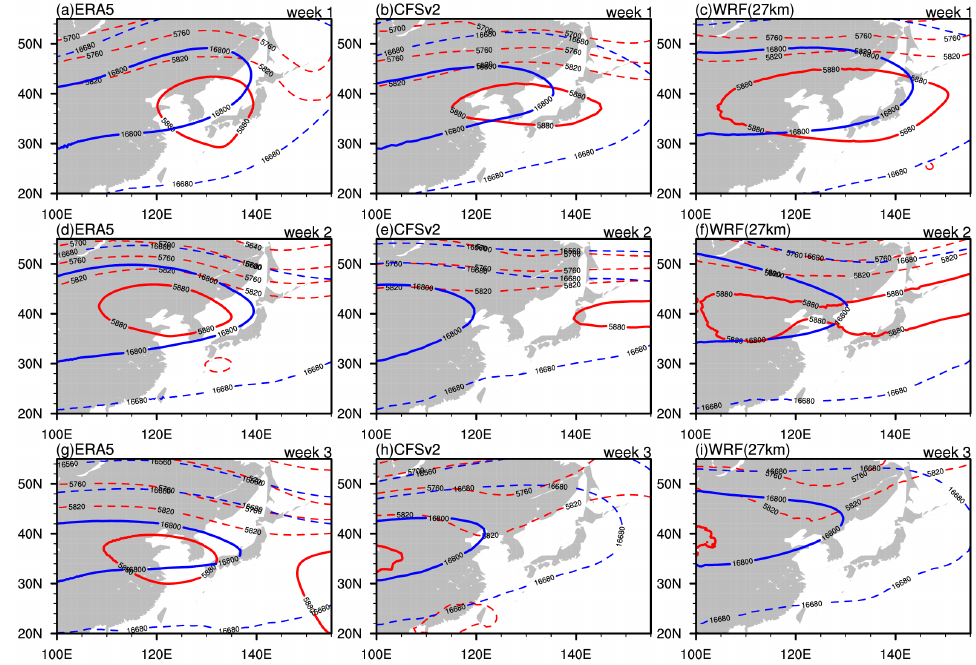
Figure 7. Spatial patterns of the mean geo-potential hieght (m) at 100 hPa (blue contour) and 500 hPa (red contour) during Weeks 1–3 in CASE 2. The blue bold line represents the Tibet High and the red line represents the North Pacific High.